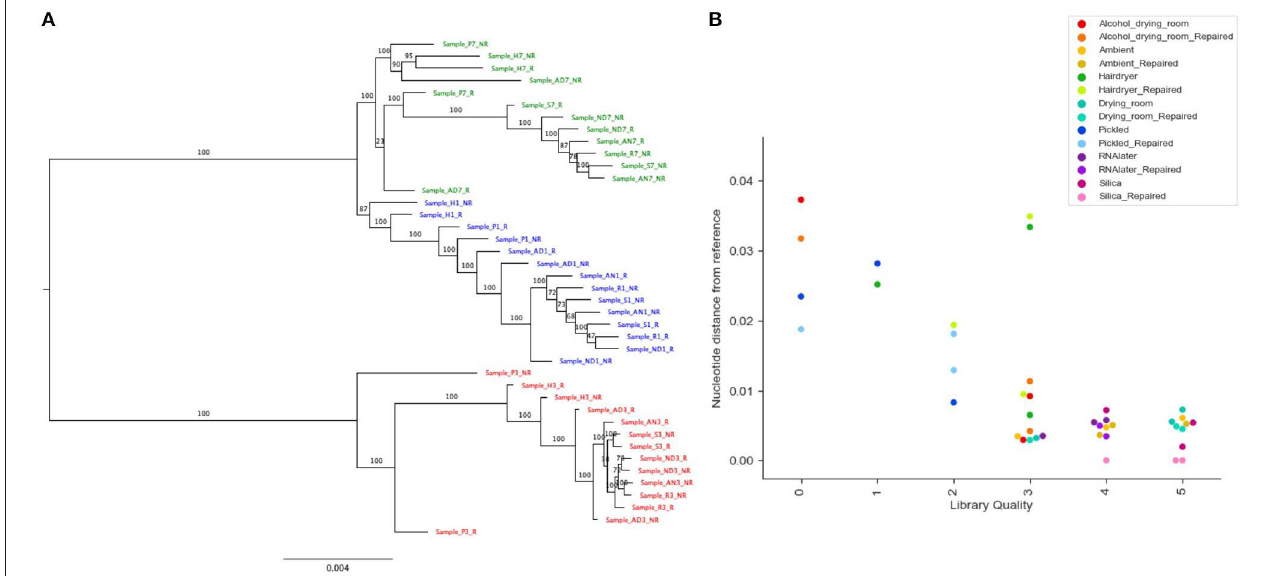
FIGURE 5 | Phylogenetic analysis of recovered sequence. (A) Phylogram of consensus sequences from each sample. Produced using RAxML from a trimmed Mafft alignment of a concatenation of all consensus bait sequences. Samples from B. bipinnatifida are colored in blue, B. serratipetala in green and from B. trichopoda in red. B. trichopoda was designated outgroup. Numbers on the branches represent ML Bootstrap supports. Sample codes represent the tissue preservation treatments, and whether the DNA was FFPE repaired or not. (B) Genetic distance of sample from reference (silica dried repaired consensus) by library quality (arbitrary scale, x-axis), by treatment (color of marker), by repair (shade of marker). Calculated from Mafft alignment using